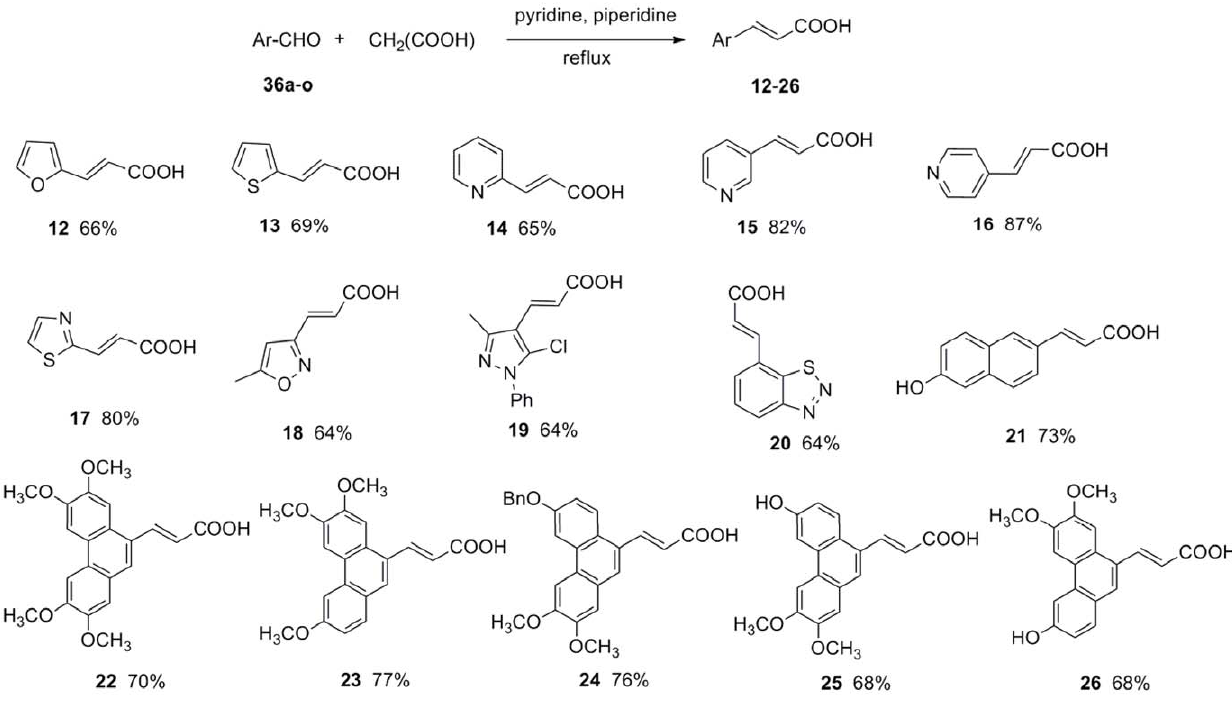
Figure 3. Synthesis of trans -3-aryl acrylic acids (12–26).